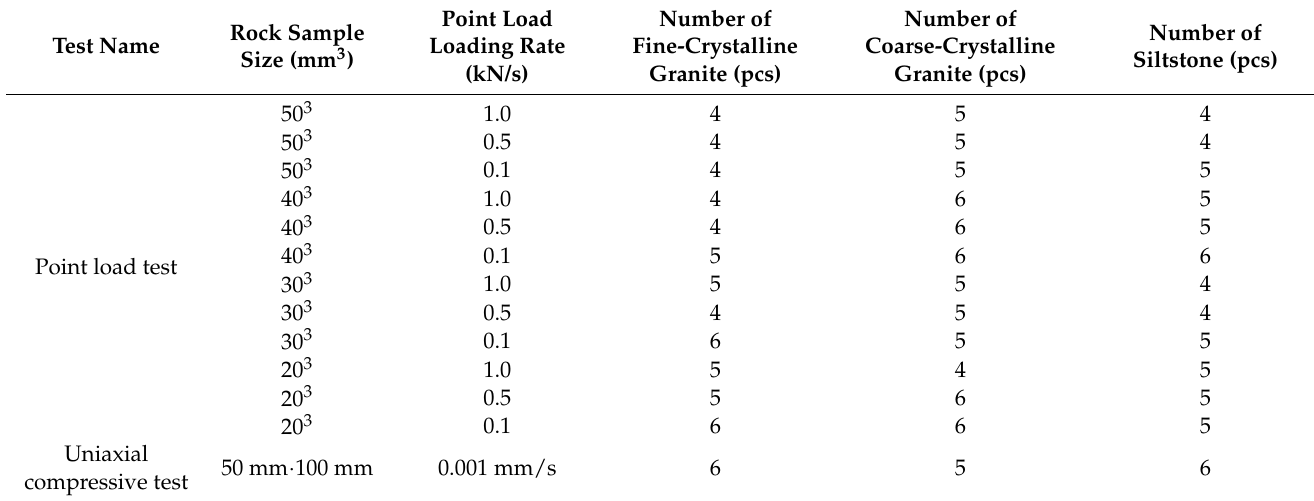
Table 2. Summary of rock sample sizes and